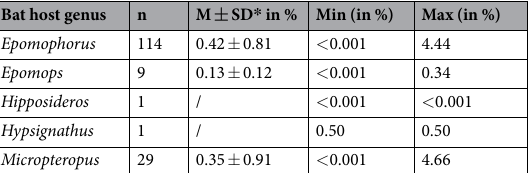
Table 2. Parasitemia of Hepatocystis infections – host genera. Table 2 Mean parasitaemia (M), Standard Deviation (SD) as well as maximum (Max) and minimum (Min) parasitaemia of Hepatocystis infections are given in % for each bat genus.